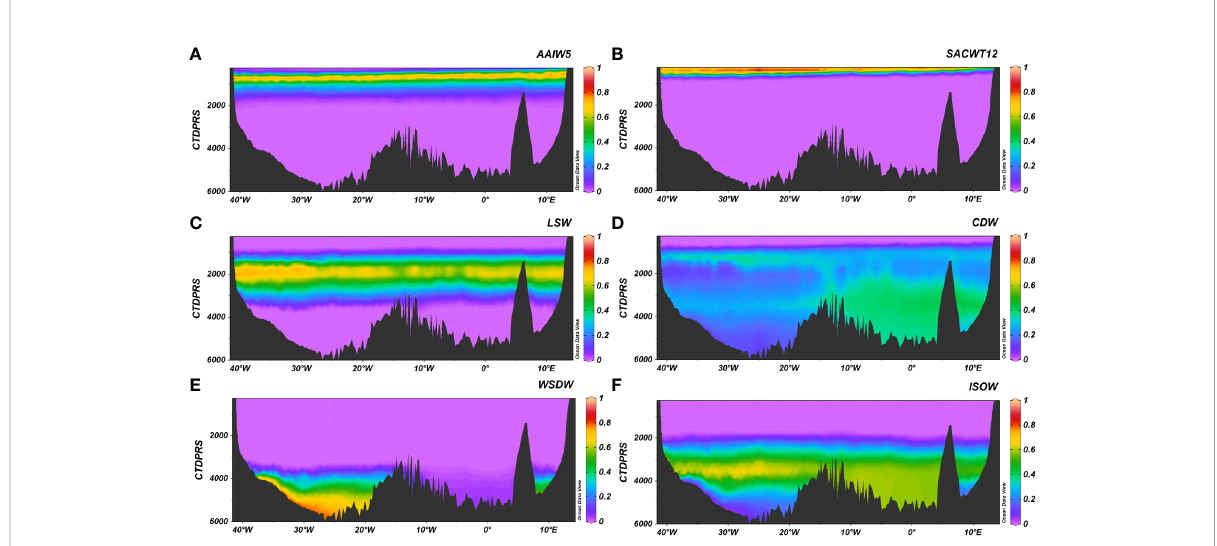
FIGURE 7 A9.5 section for the contribution of the water masses (A) AAIW5, (B) SACWT12, (C) LSW, (D) CDW, (E) WSDW, (F) ISOW. Figure with the Ocean Data View software (Schlitzer, 2015).